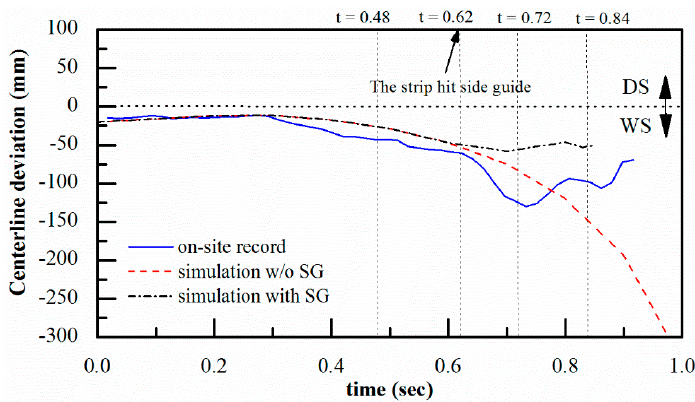
Figure 9. Comparison of centerline deviation between on-site record and simulated results.